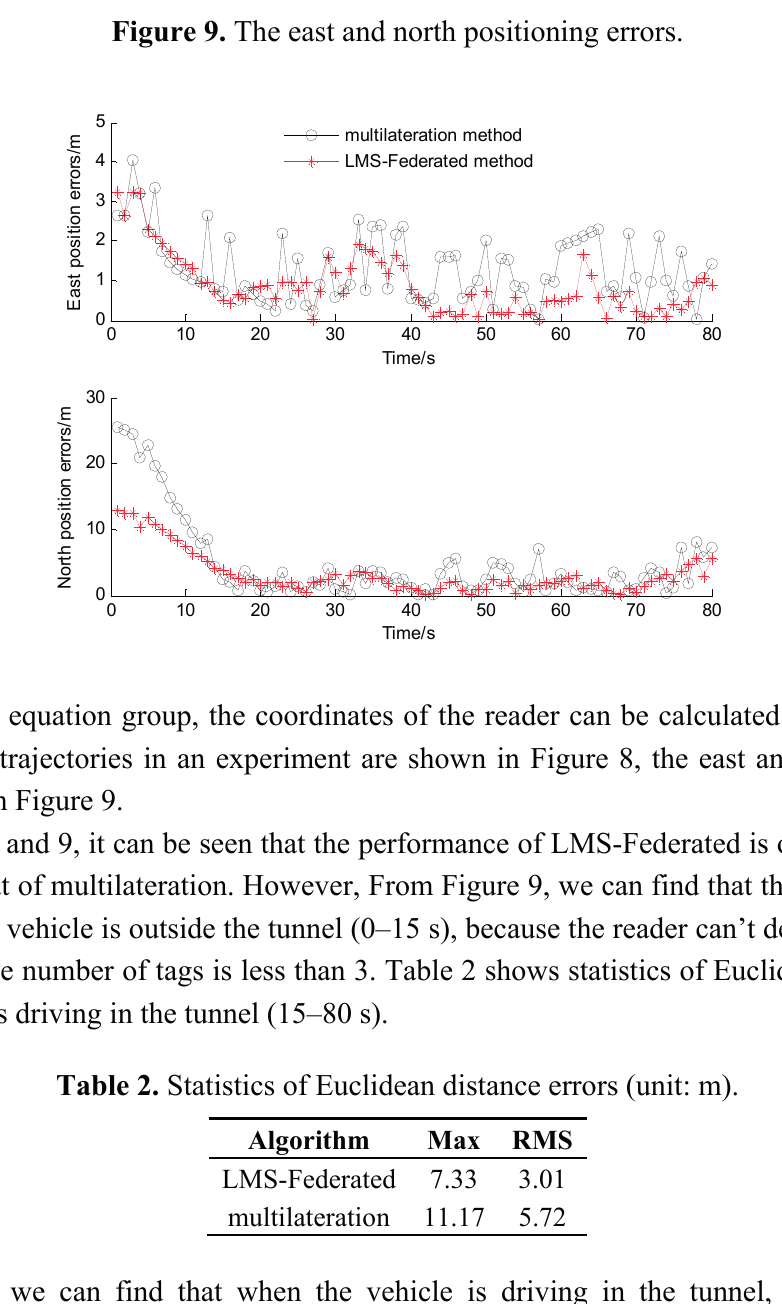
Figure 9. The east and north positioning errors.